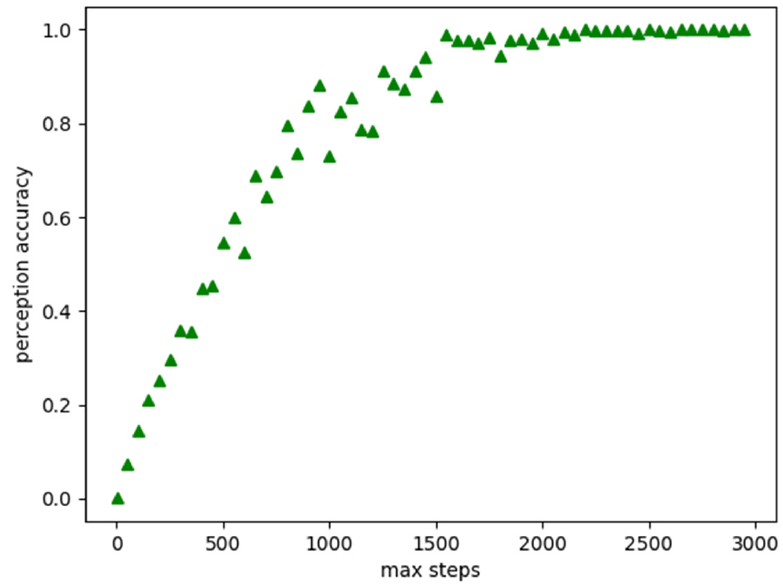
Figure 6. Relationship between MAS and